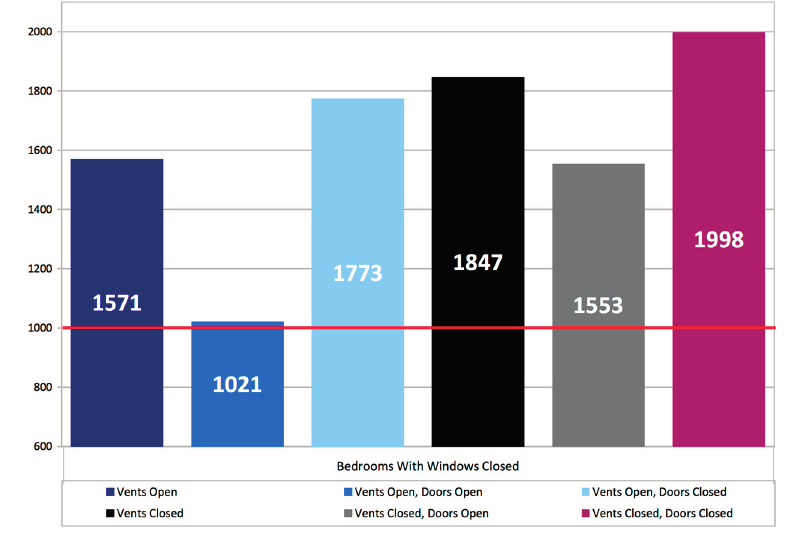
Figure 5. Bedrooms with windows closed-average CO 2 ppm, time weighted average between 11 pm and 7